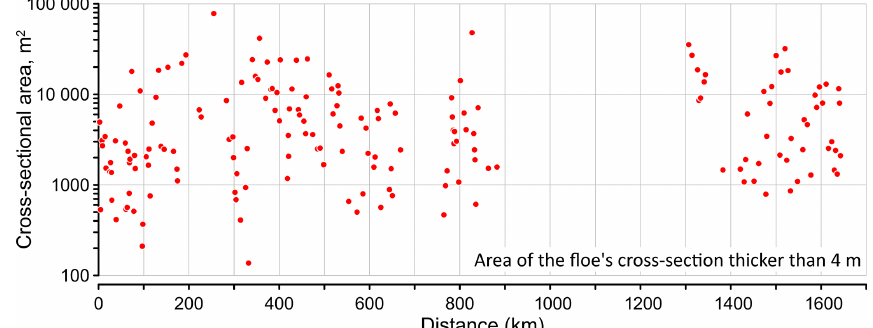
Figure 18. An index of the navigational hazard posed by individual thick floes identified along the survey path. The index in the cross- sectional area of all ice thicker than 4m in each